Question: Summarize what this figure shows in one sentence.
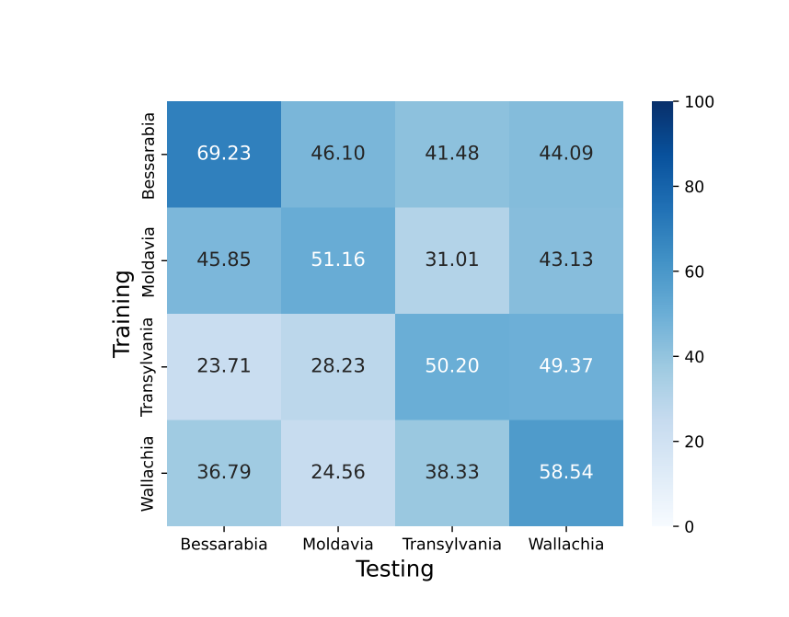
Answer: Inter-regional strict F1-scores of the RoBERT-large model.